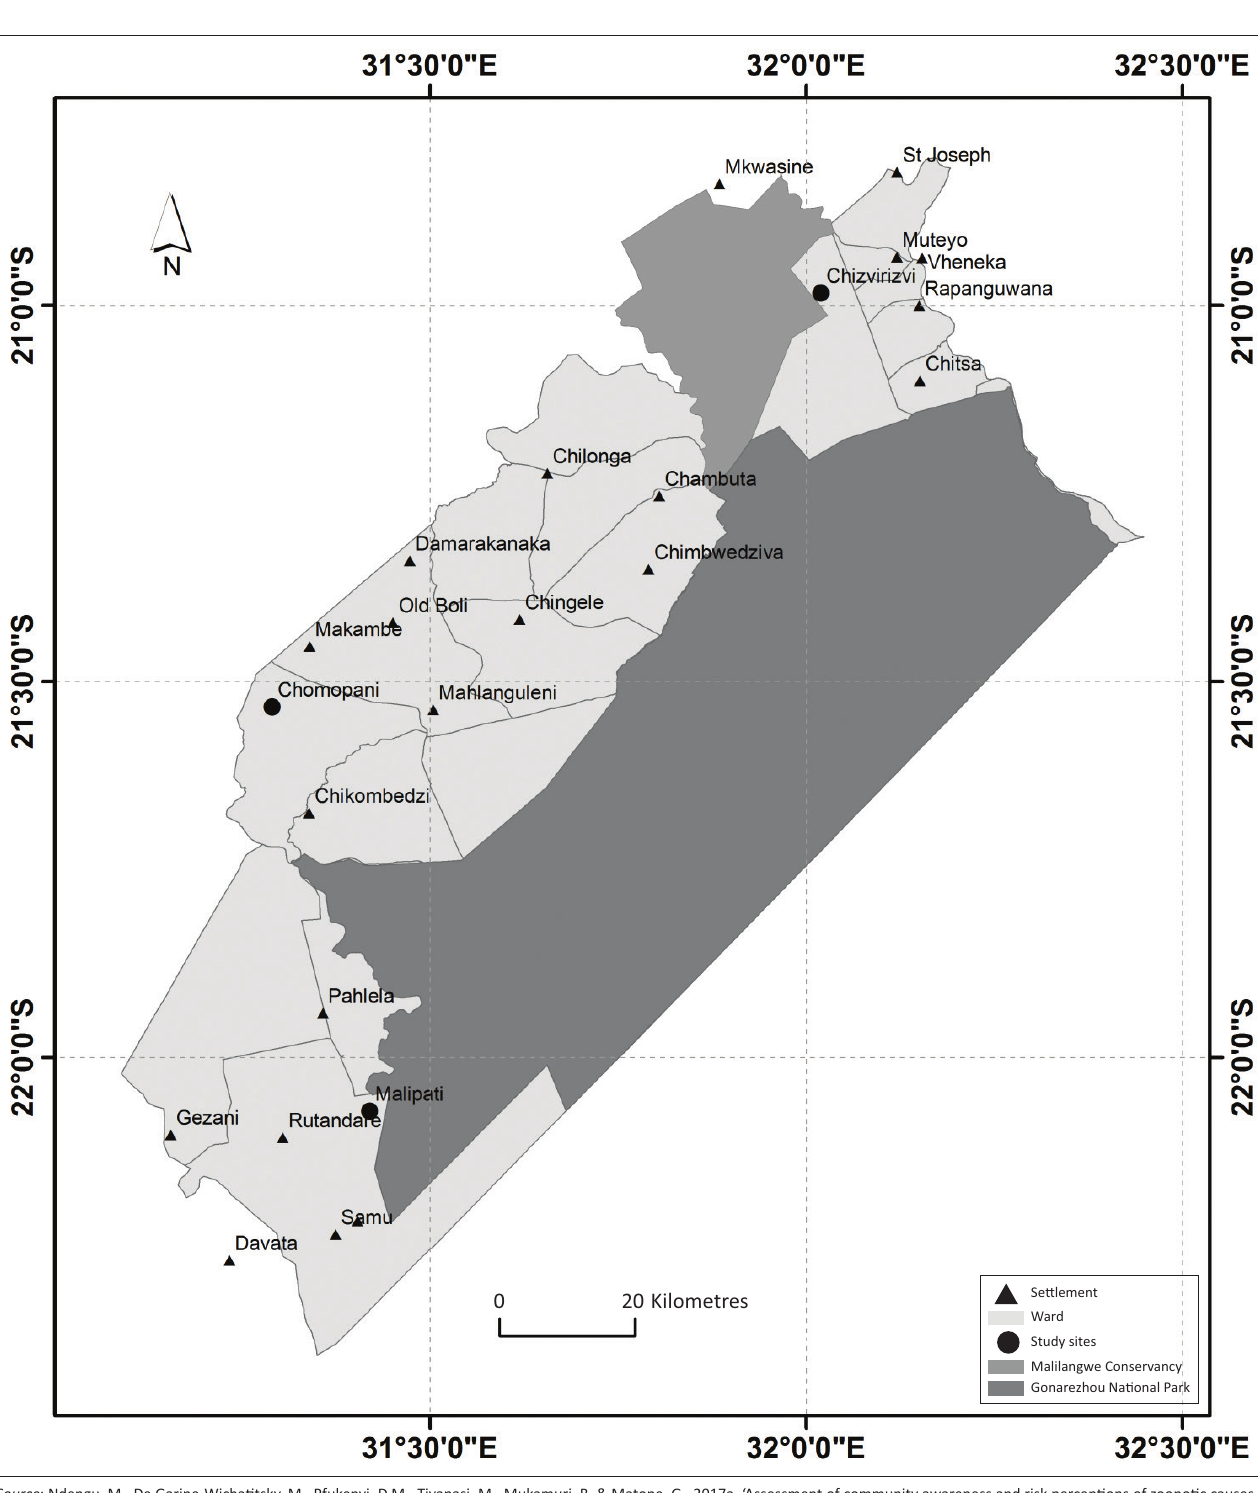
http://www.ojvr.org